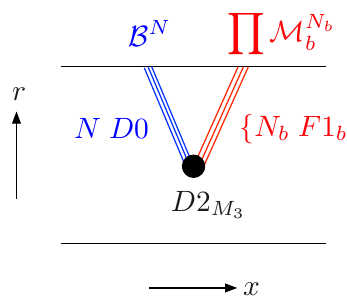
Figure 6 . Holographic description of the chiral-ring relation. The vertical axis (labeled by r ) represents the radial coordinate of AdS 7 , with r = 0 at the bottom and r = horizontal axis (labeled by x ) represents any of the other